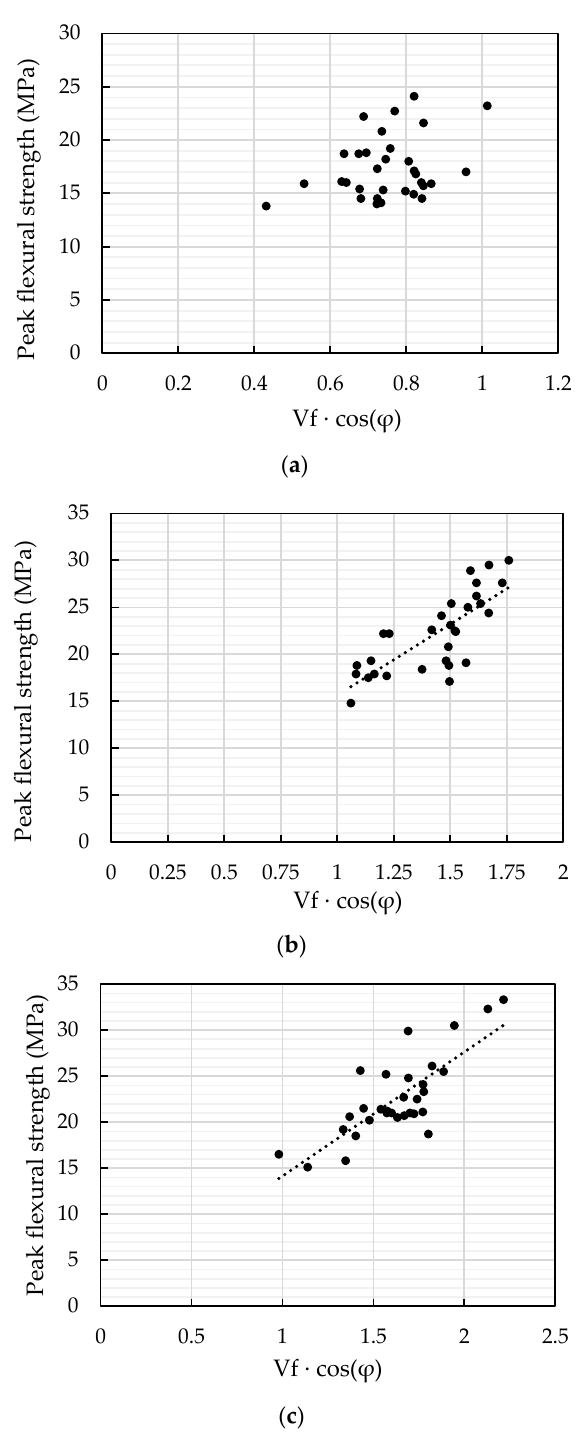
Figure 17. Relationship between V f × cos(φ) and peak flexural strength. ( a ) 1% vol. UHPFRC; ( b ) 2% vol. UHPFRC; and ( c ) 2.5% vol. UHPFRC.